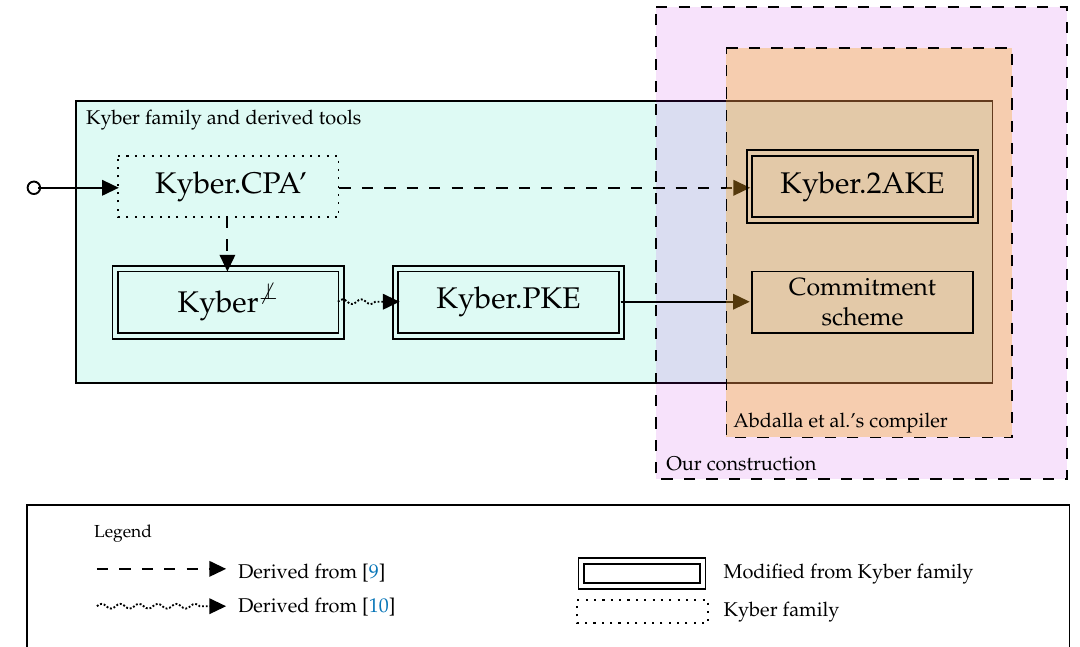
Figure 1. Workflow of our construction.